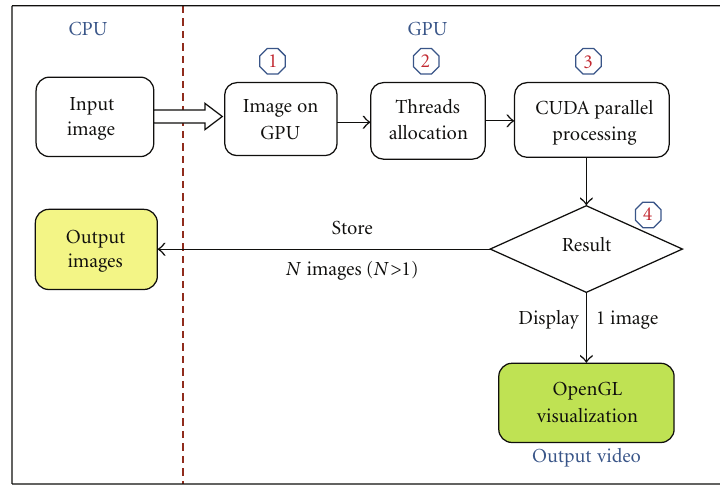
Figure 4: Image Processing on GPU based on CUDA and